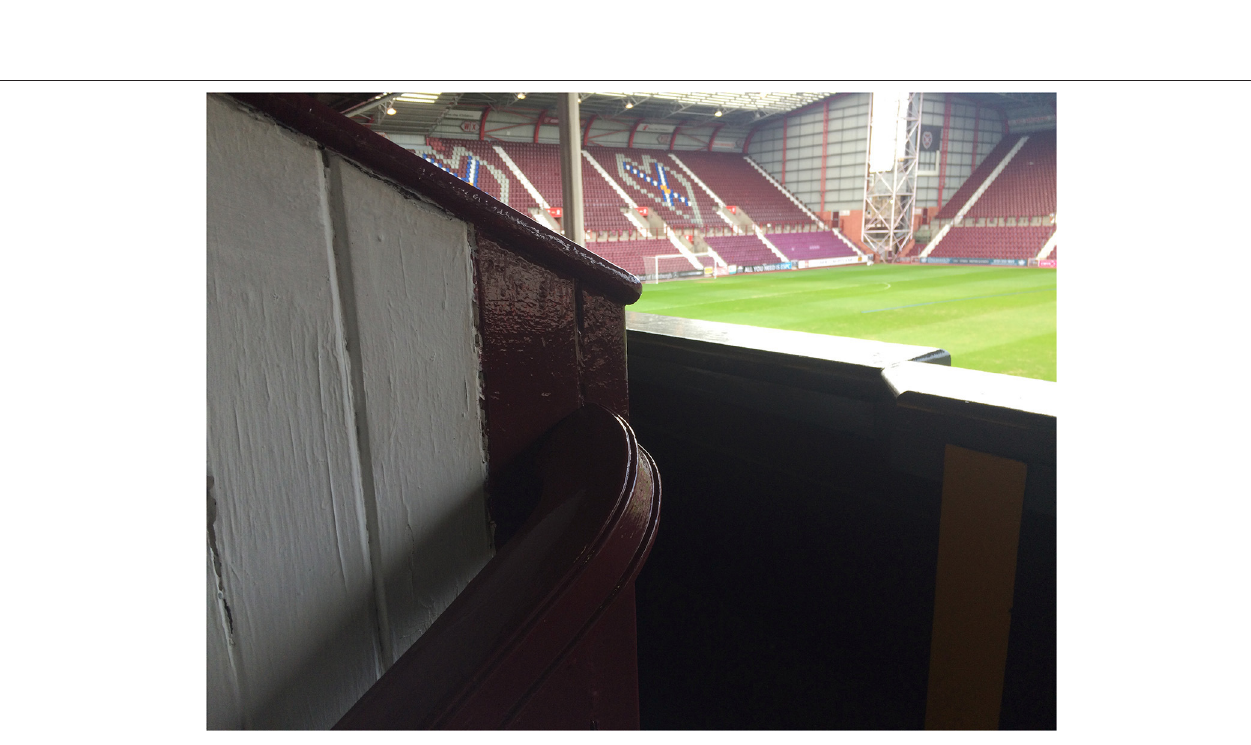
Frontiers in Sports and Active Living |